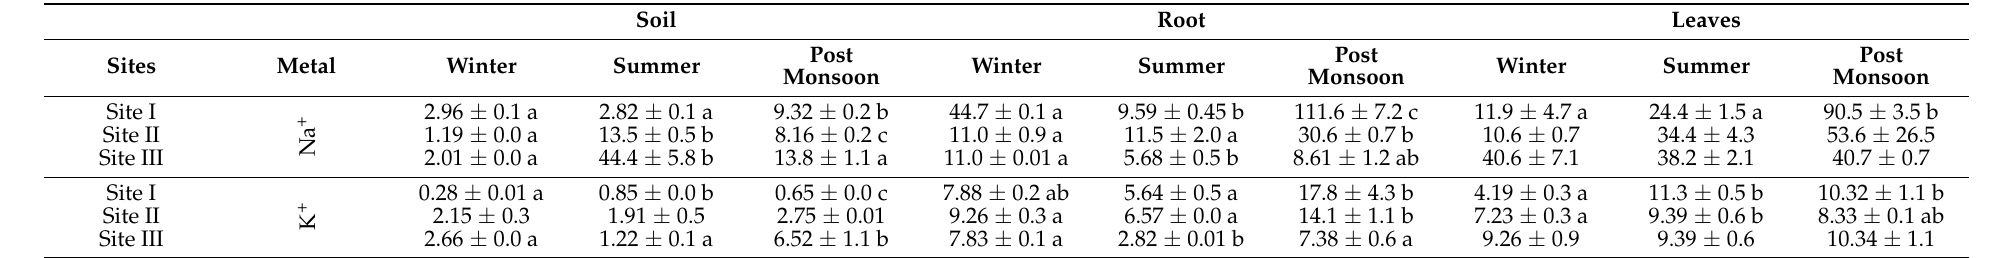
Table 2. Na + and K + (g kg − 1 ) content in soil, root, and leaves of Salvadora persica at Sandspit (Site I), Clifton (Site II) and Korangi (Site III). Different letters on error bars indicate significant differences among season on the same site ( n = 3) at p ≤ 0.05. (Bonferroni/Games-Howell tests wherever applicable). Soil Root